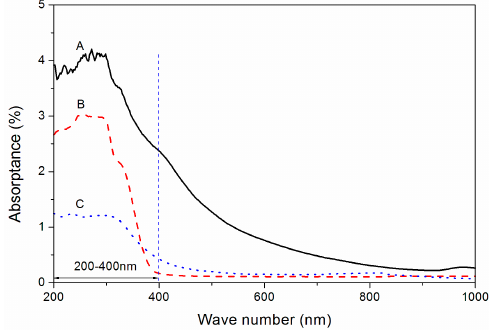
Figure 5. UV-Vis spectrum of WUVCW after adding CaCO 3 and talcum ( A ) before curing, ( B ) UV radiation time of 30 s, ( C ) UV radiation time of 1.0 min (sample 6 in Table 1).